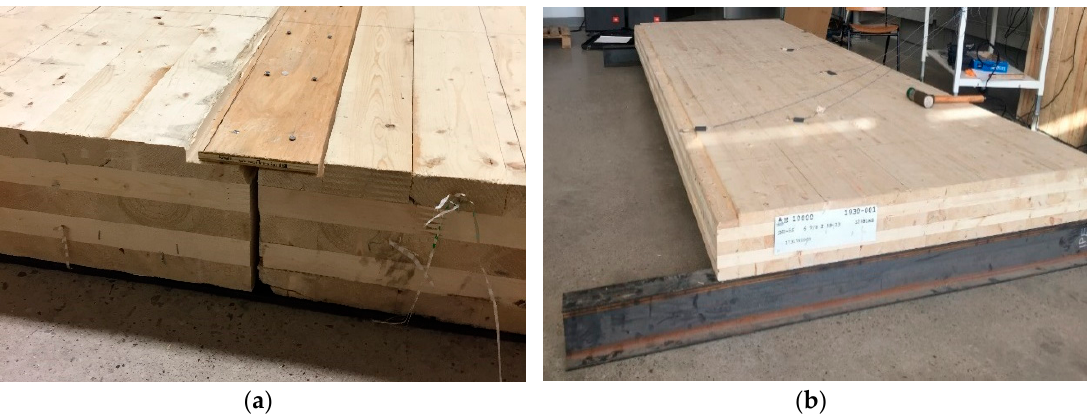
Figure 1. ( a ) Two CLT panels connected by a thin wooden lath. ( b ) One CLT panel simply